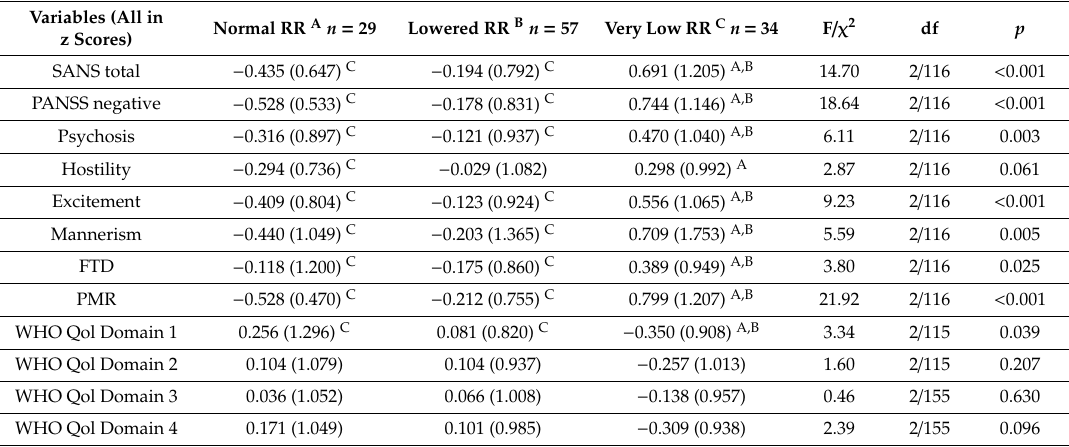
Table 3. Measurements of the symptomatome and phenomenome in the participants divided according to a risk resilience (RR)